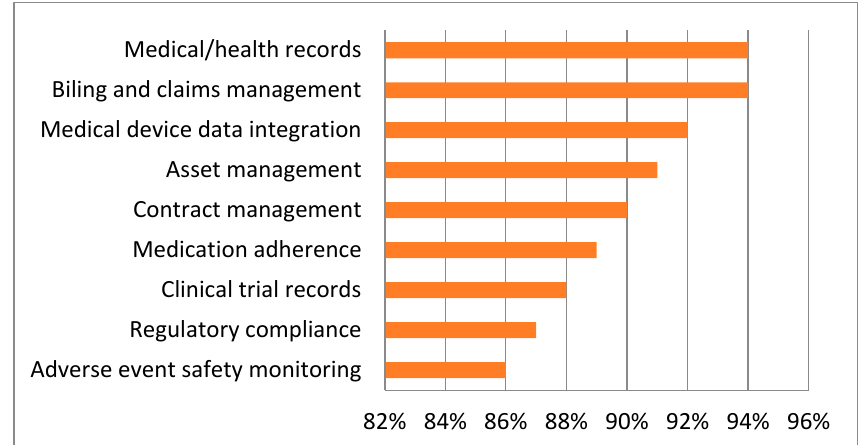
Figure 2. Investment of healthcare industries in the blockchain [2,3].